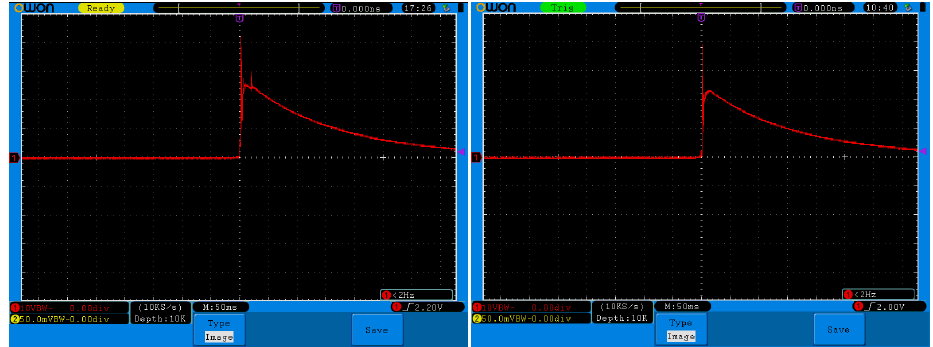
Figure 7. Peak amplitude after 1 h (642 cycles) and after 100,000 cycles. Vertical 10 V per cm, Horizontal 50 ms per cm.